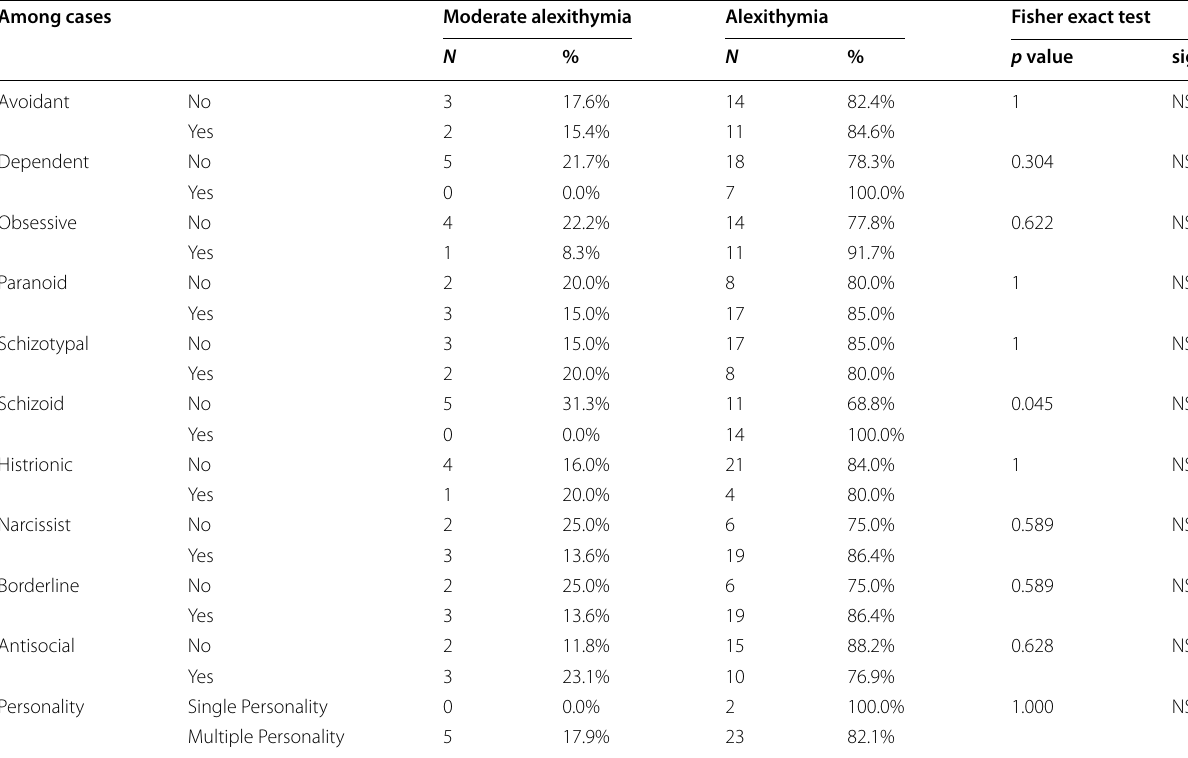
NS non-significant, S significant